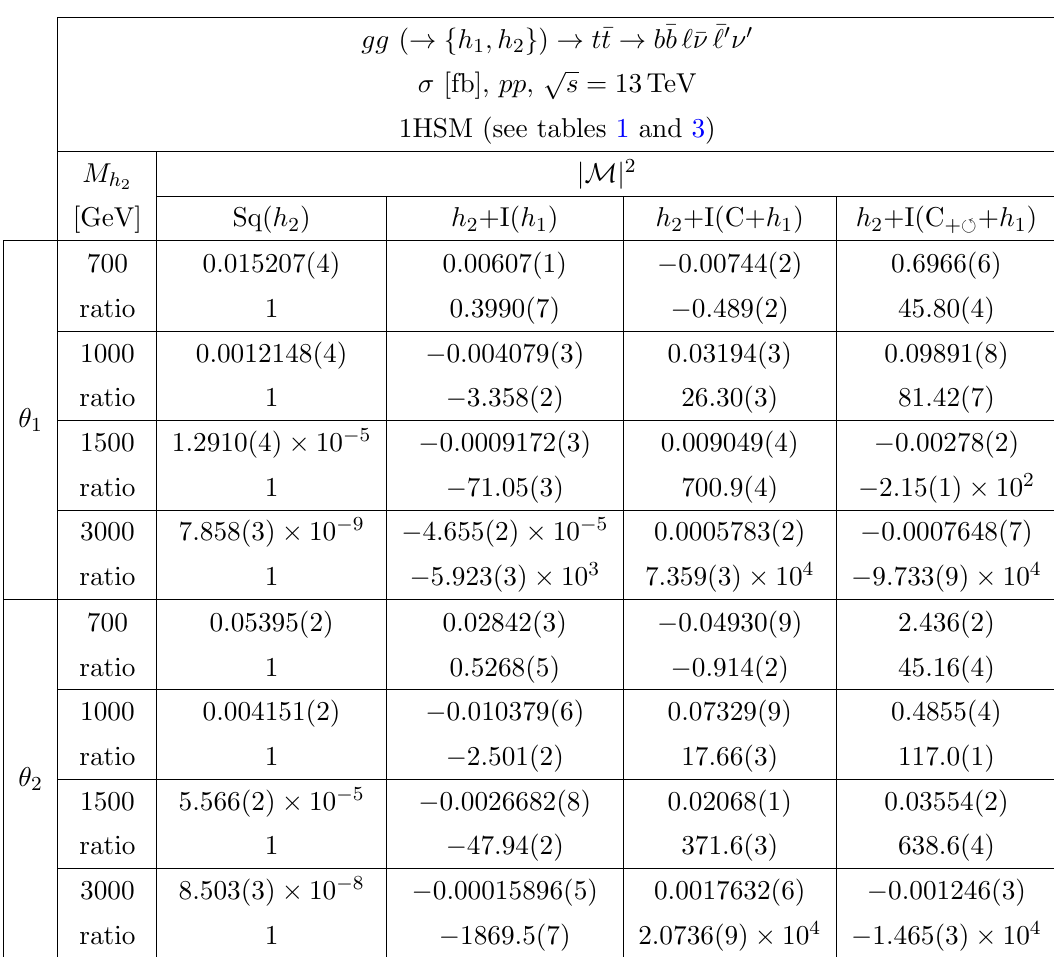
the 1HSM with focus on heavy Higgs production. Other details as in table